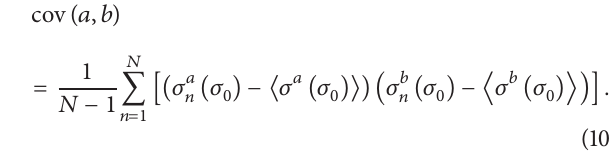
to redevelop such libraries from continuous nuclear data, the FCWG method provides a methodology for approximating the dilution impact on